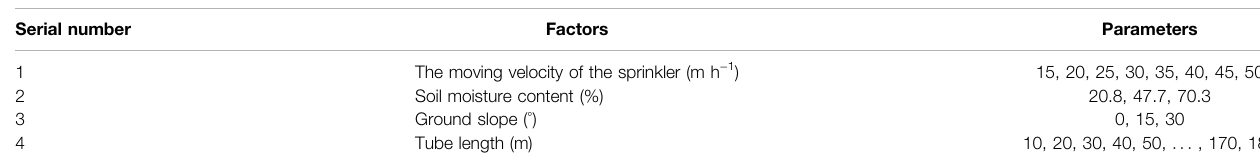
TABLE 1 | Factors and parameters.